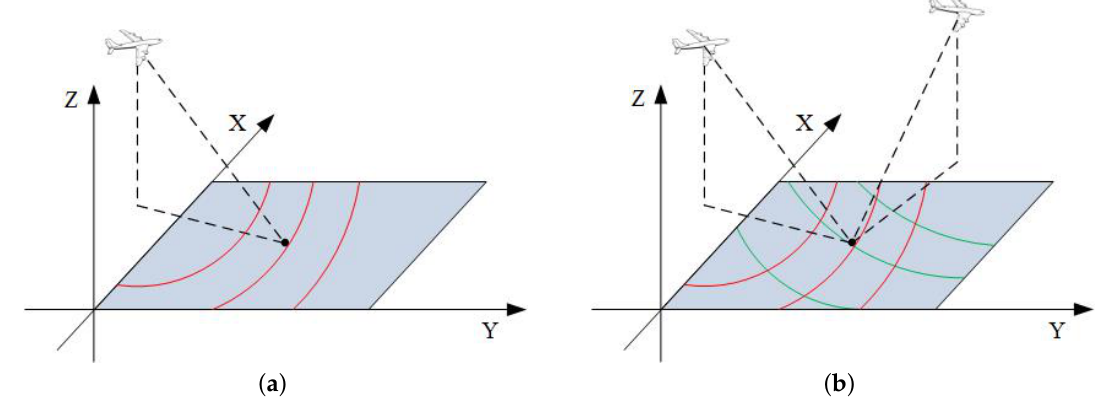
Figure 3. Spatial variance of high frequency motion error of monostatic and bistatic SAR system. ( a ) is the monostatic system. ( b ) is the bistatic